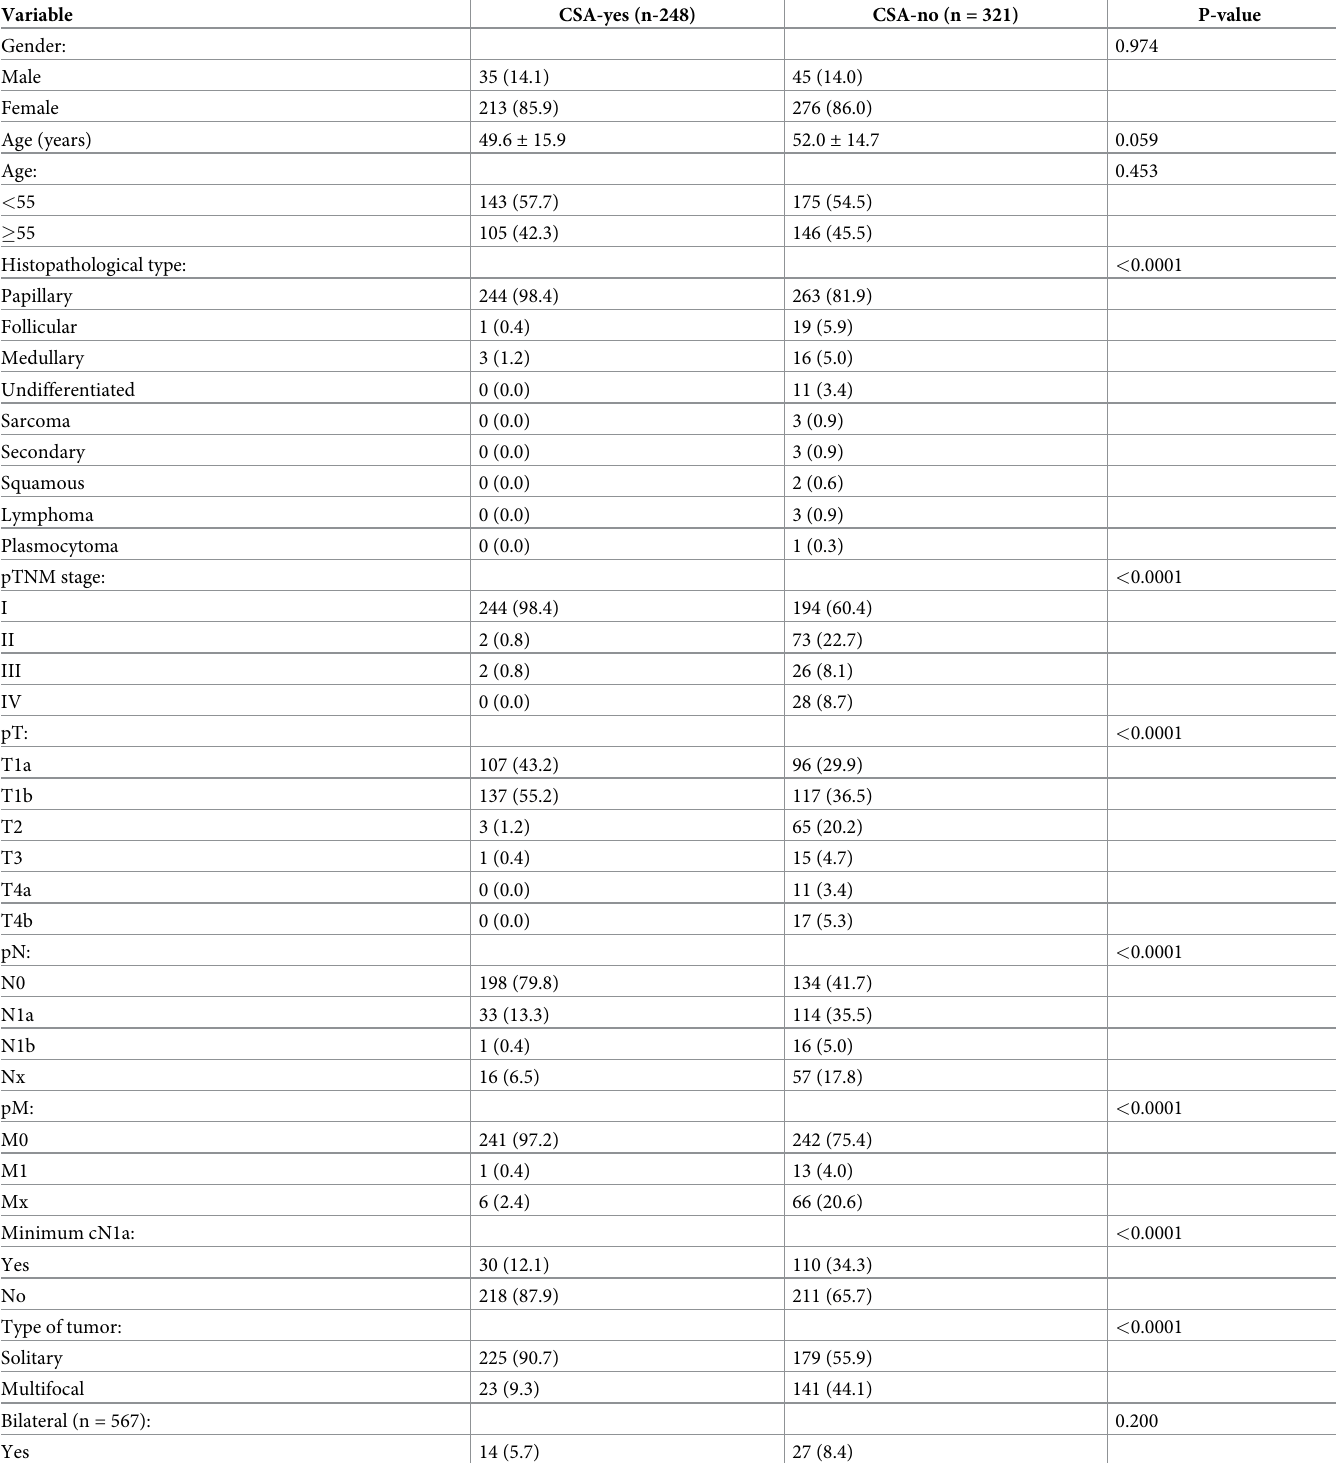
Table 1. The demographic, clinical and histopathological characteristics of thyroid cancer patients divided into the following two groups according to the imple- mentation of cancer screening activity (CSA): CSA-yes and CSA-no. Descriptive data are presented as a number (percent) or mean ±